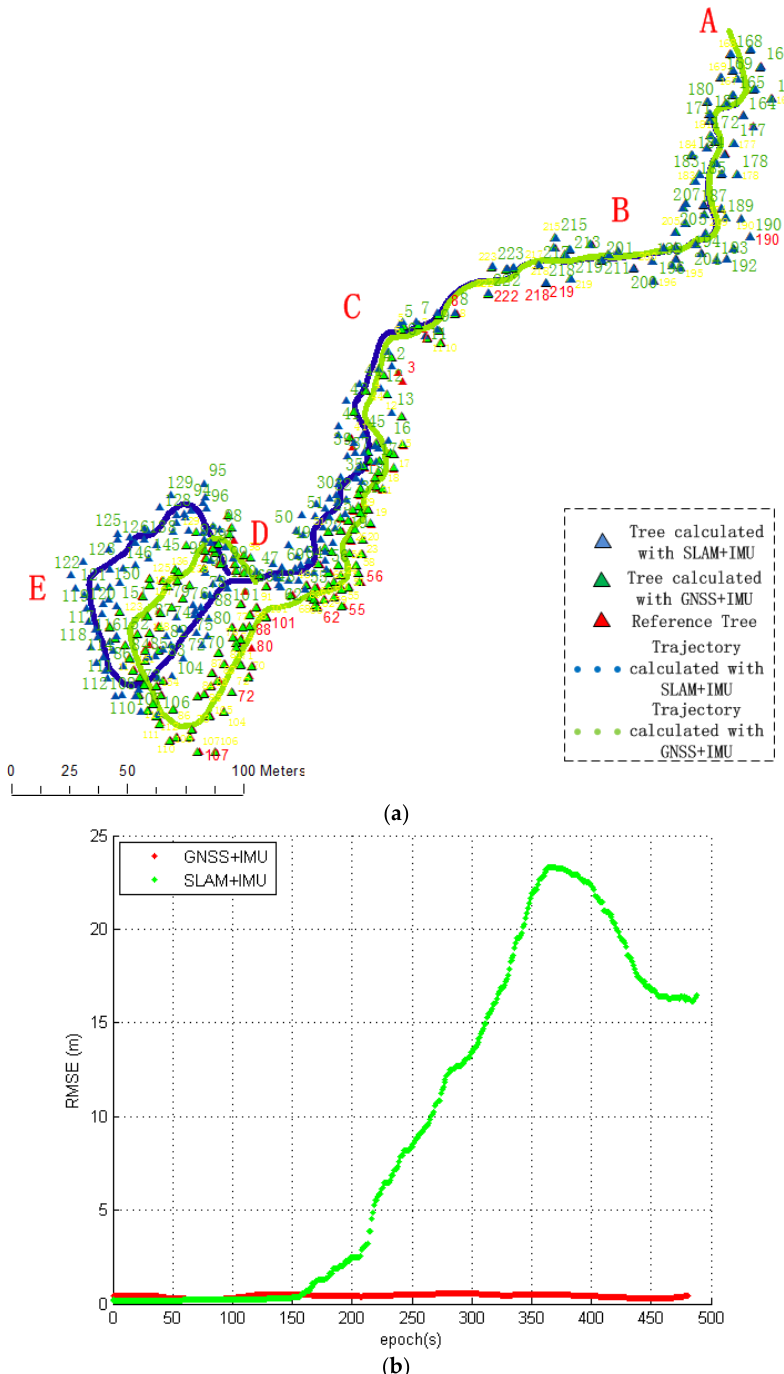
Figure 8. ( a ) Trajectories and stem position comparison between the GNSS + IMU and SLAM + IMU methods for the entire test and ( b ) positioning errors of the SLAM + IMU solution for the entire test.